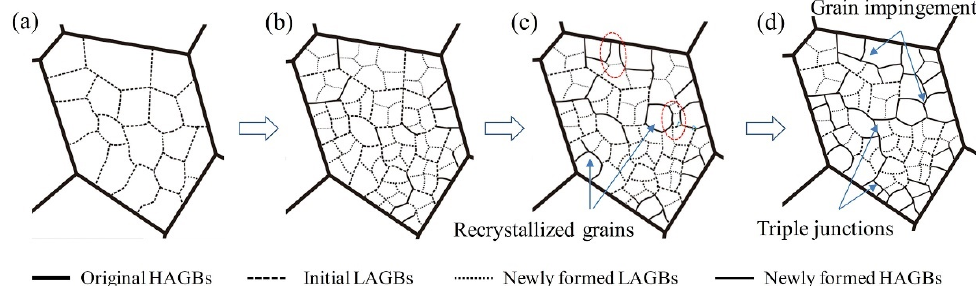
Figure 14. The proposed CDRX modelling approach by Chen et al. [220]: ( a ) initial microstructure before deformation; ( b ) microstructure change in the initial strain stage; ( c ) generation of recrystallized grains; ( d ) immobilization of recrystallized grain boundaries. Reprinted from Ref. [220] with permission. Copyright 2020, Elsevier.